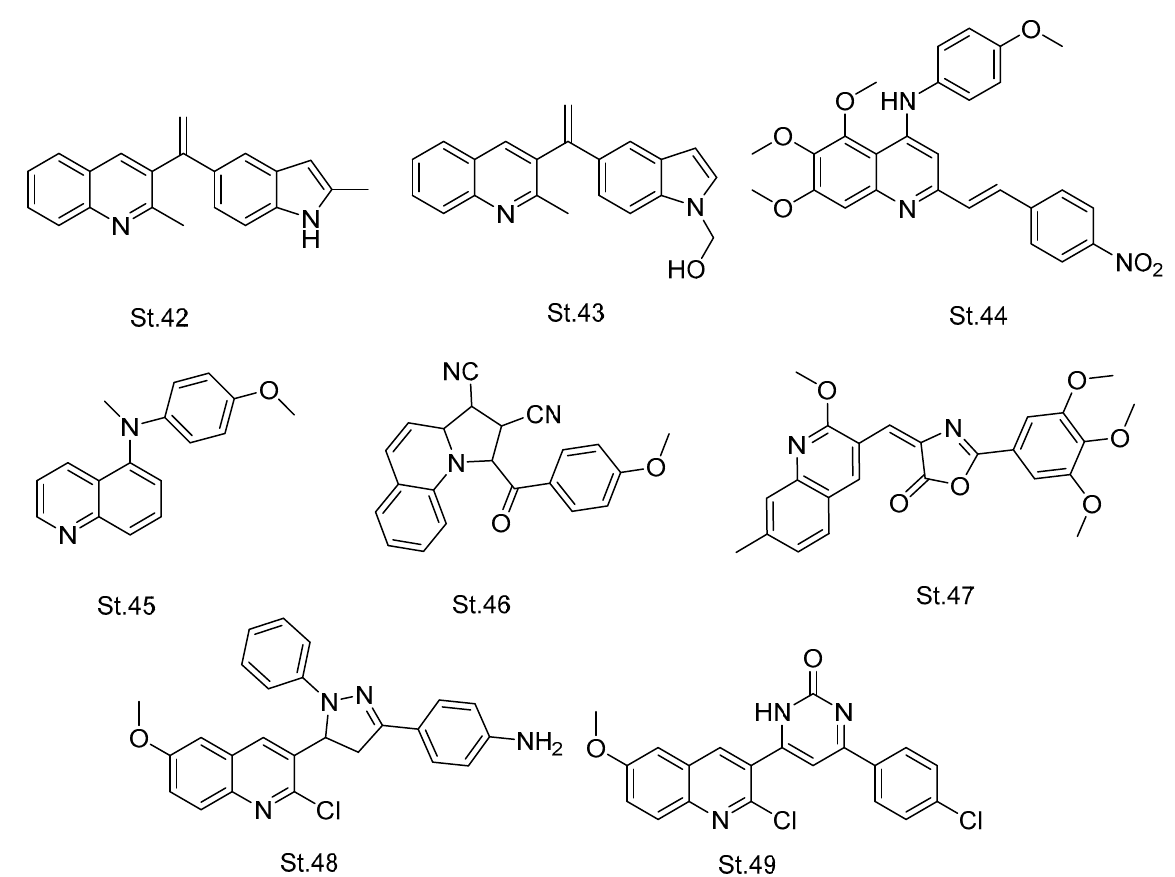
Figure 9. The structures of quinolone analogues.